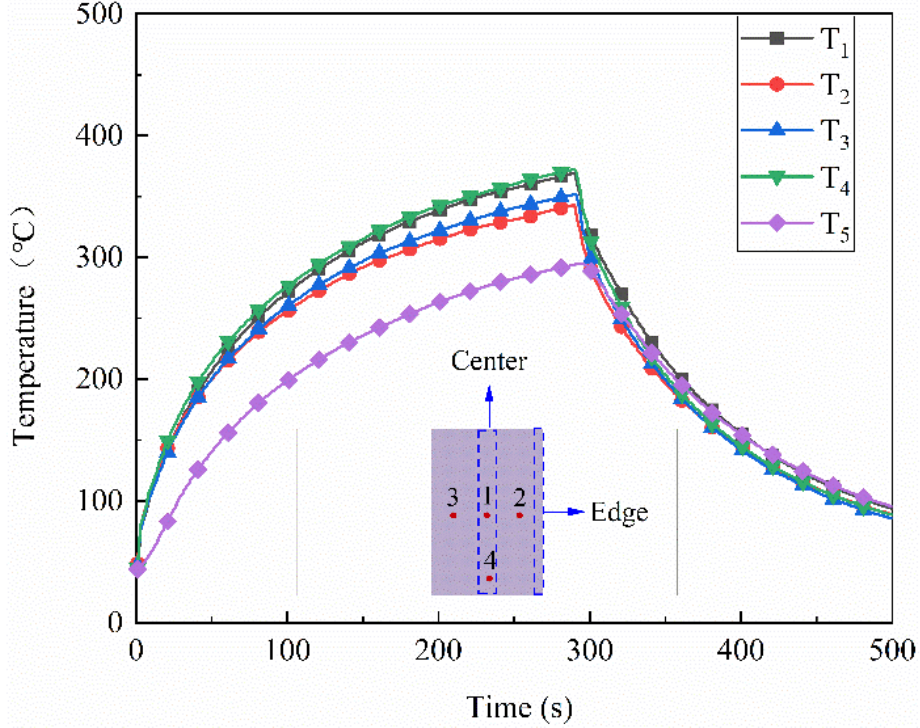
Figure 5. Temperature-time curves of welding specimens obtained with type B heating element at 51 kW/m 2 power density. Table 2. Welding time at specific temperatures and temperature differences at the joining interface obtained with type B heating element at different power densities.